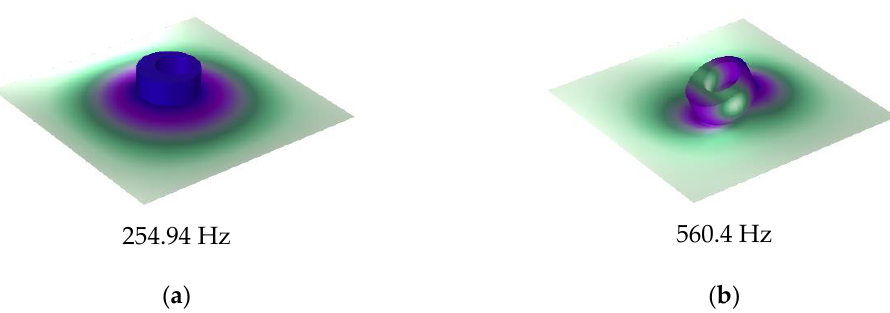
Figure 4. Eigenmodes of the single-mass-loaded membrane: ( a ) 254.94 Hz and ( b ) 560.4 Hz. Based on the single-mass model, we further calculated the STL of MAM containing multiple masses. As shown in Figure 5a, two mass blocks were distributed on the membrane with x 0 = 5 mm, whose eccentric directions were the same. The distribution position was symmetrical, but due to the asymmetry of the mass, the whole structure was asymmetric to the y -axis. Figure 6a shows the STL curve calculated by the finite element method